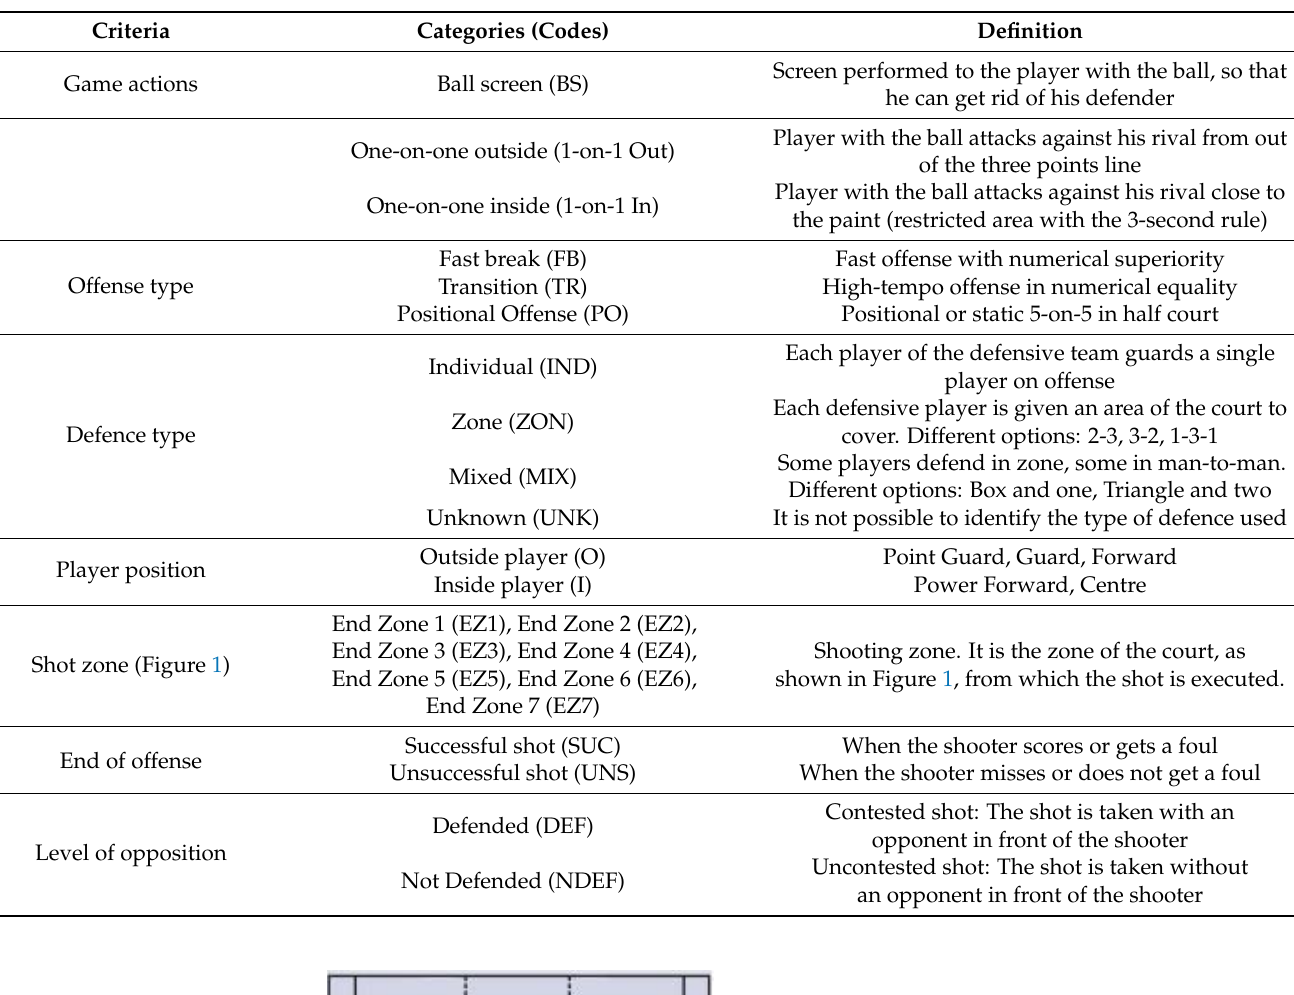
Table 2. SOCCB criteria and categories.